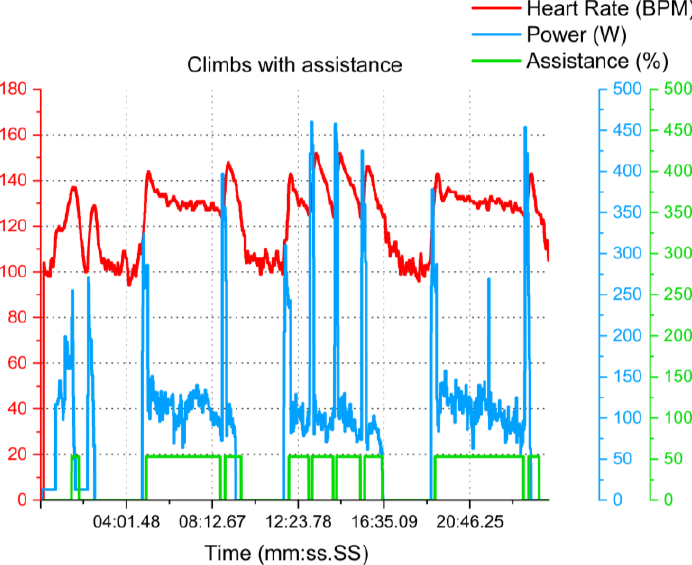
Figure 13. Example (N = 1) of outdoor test results. Three climbs were carried out in Pech David with cardiac zone monitoring. Table 6. Overall outdoor results (mean and standard deviation).